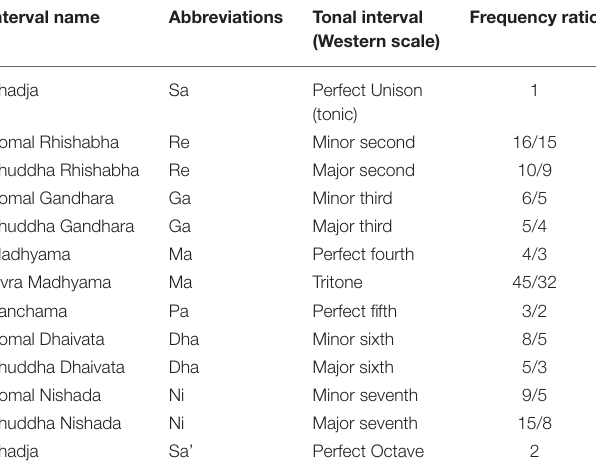
TABLE 1 | Indian/western tonal interval equivalences and frequency